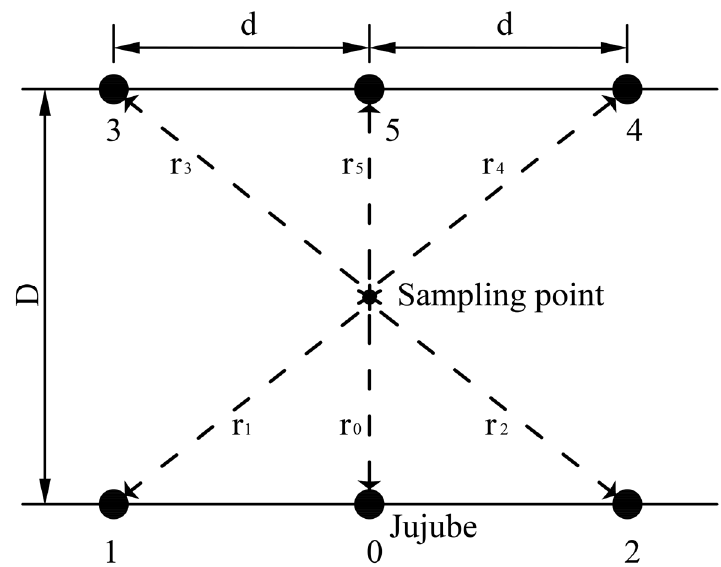
Figure 3. Schematic of jujube root two-dimensional distribution model. The abbreviations of r 0 , r 1 , r 2 , r 3 , r 4 , and r 5 are the distance between the root of jujube tree and the sampling point. D is row spacing, d is plant spacing.